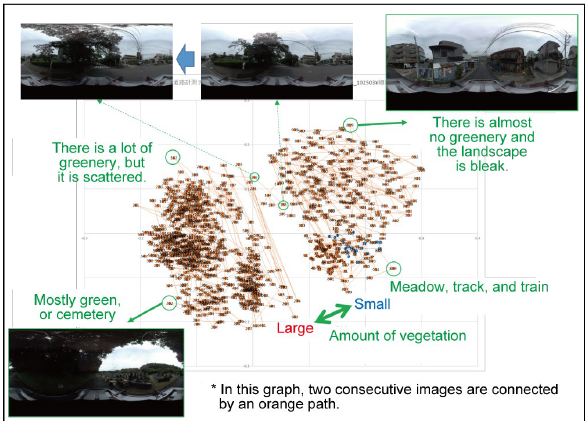
Figure 2. Example of a two-dimensional planar plot of 1,000 consecutive image feature vectors.